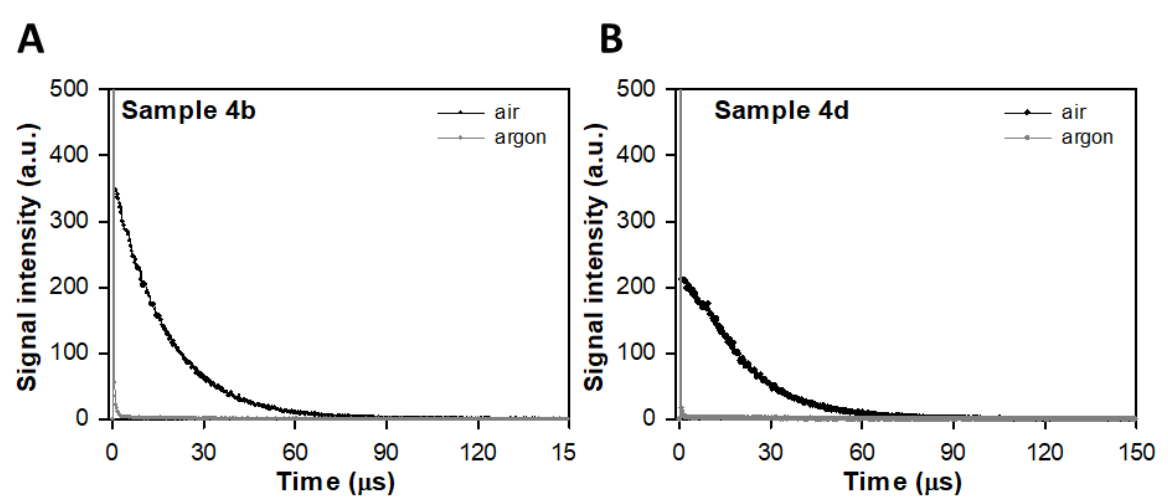
Figure 2. Singlet oxygen ( 1 O 2 , 1 Δ g ) phosphorescence decay detected at 1270 nm after laser excitation of selected samples: 4b ( A ) and 4d ( B ) in DMSO: ethanol solution (1:1, v / v ) with 420 nm. Studied samples solutions were equilibrated with air (black) or saturated with argon (grey).